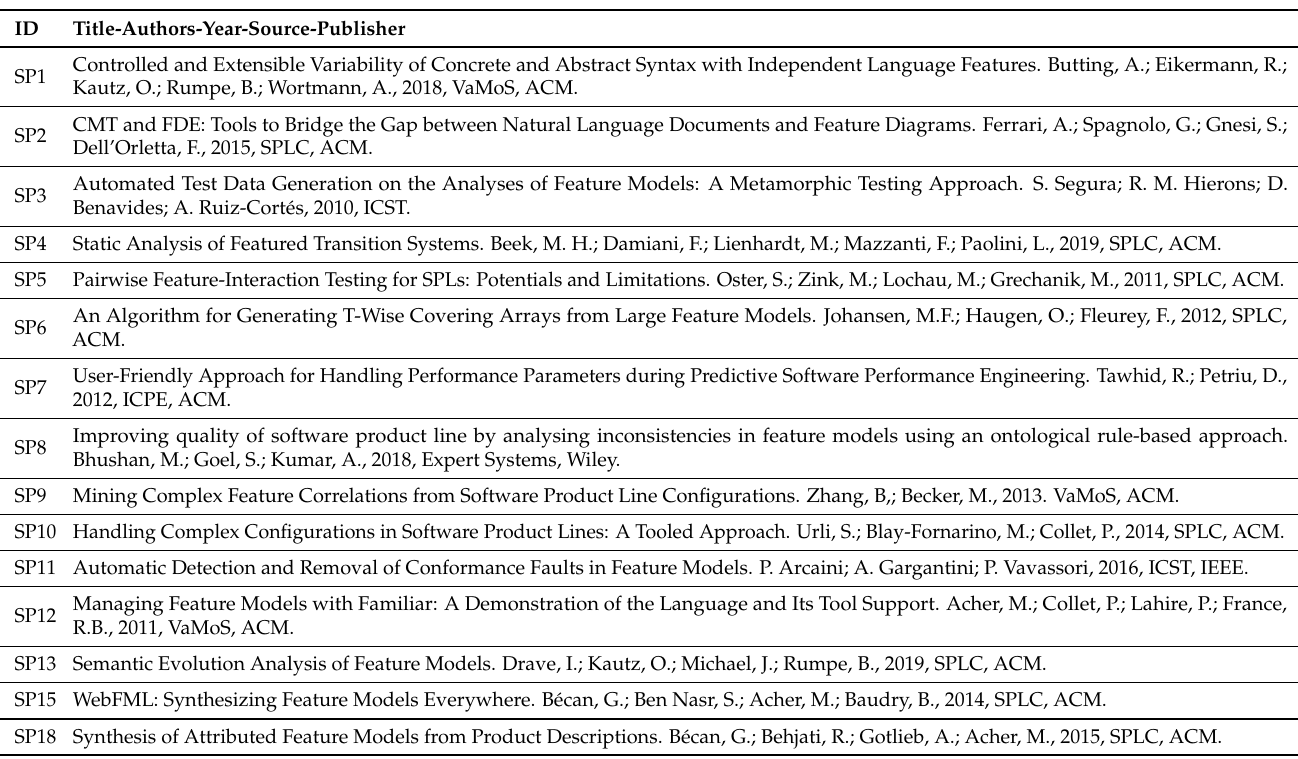
Table A3. List of selected